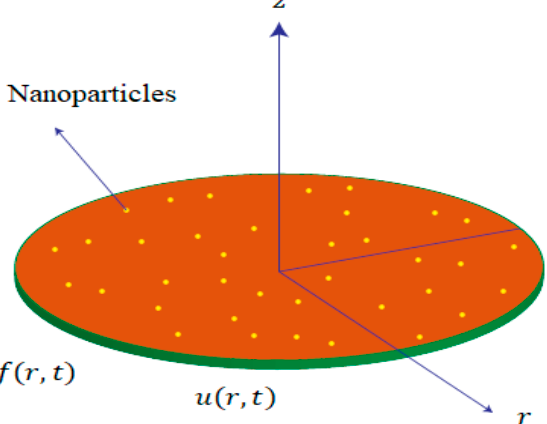
Figure 1. Geometry of desired model.